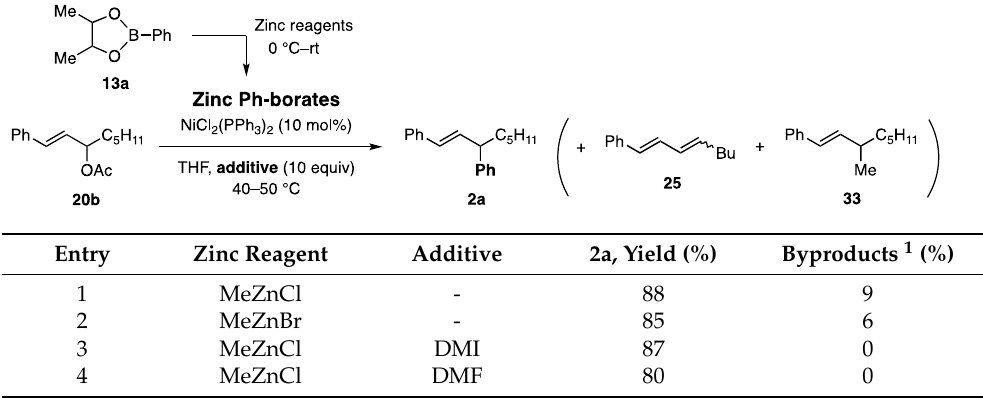
Figure 2. Zinc borates prepared for allylic coupling reaction.